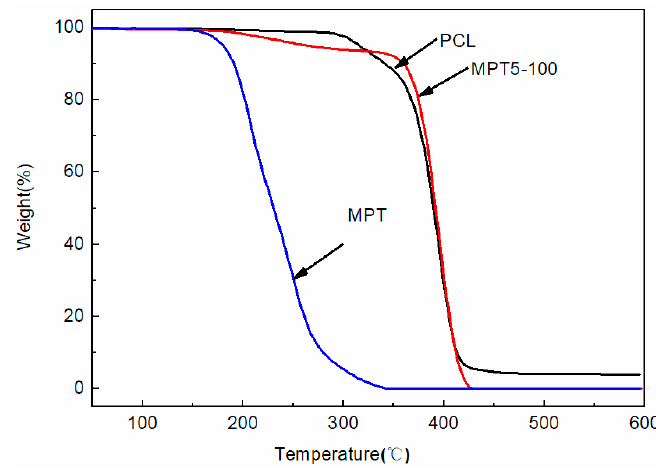
Figure 1. TGA curves of PCL, MPT, and PCL/MPT. The FTIR spectra of PCL, MPT, and the PCL/MPT blends are shown in Figure 2, with different weight ratios of PCL/MPT and processing temperatures. The bands at 2938 and 2868 cm − 1 from pure PCL correspond to the symmetric and asymmetric stretching vi- brations of -CH 3 , and the peak at 1718 cm − 1 corresponds to the asymmetric stretching vibrations of C=O, which are in accordance with the data reported earlier [16]. The ab- sorption band at 3455 cm − 1 and the small broad band at 1633 cm − 1 are related to the vibration of N-H bonding of MPT, while the broad peak ranging from 3300 to 2500 cm − 1 is formed by the stretching vibration of O-H [32]. The FTIR spectrum of MPT is in accordance with the results reported elsewhere [33]. Compared with the FTIR curves of pure PCL and MPT, no new absorption peak appeared for PCL/MPT blends processed at different temperatures (100 and 130 ◦ C), indicating that no chemical variations occurred during the hot-melt processing.